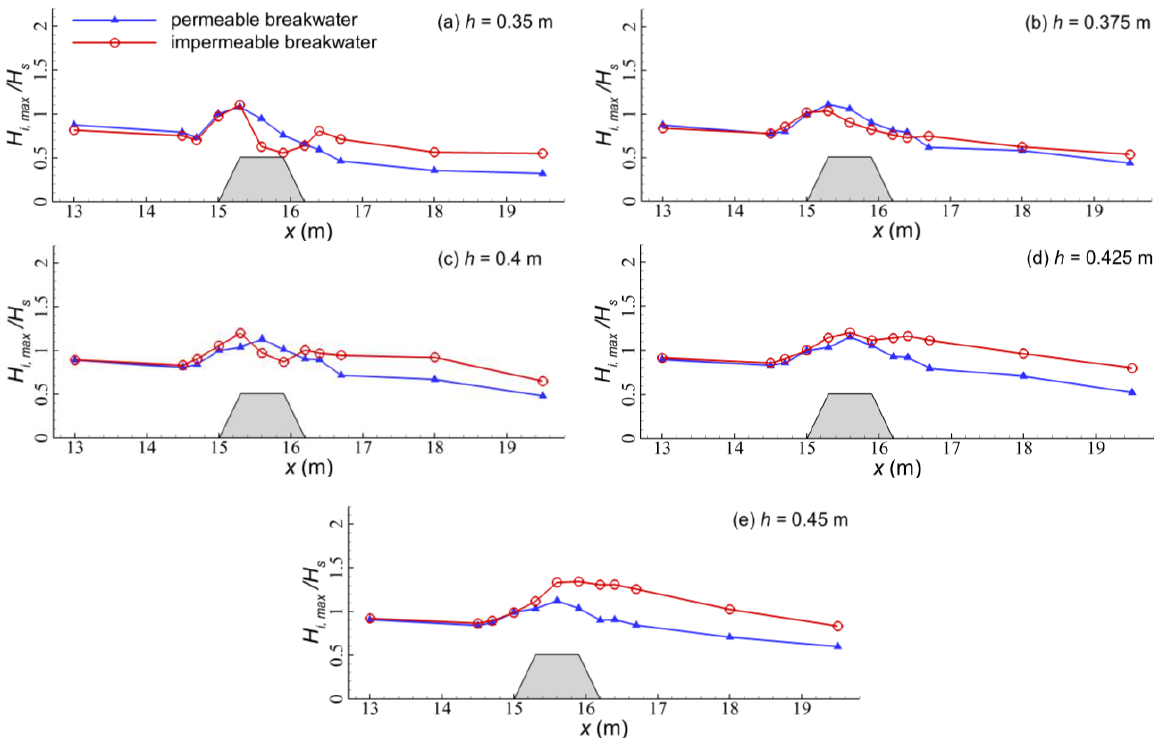
Figure 17. Spatial distribution of the maximum local wave heights with different water depths; ( a )